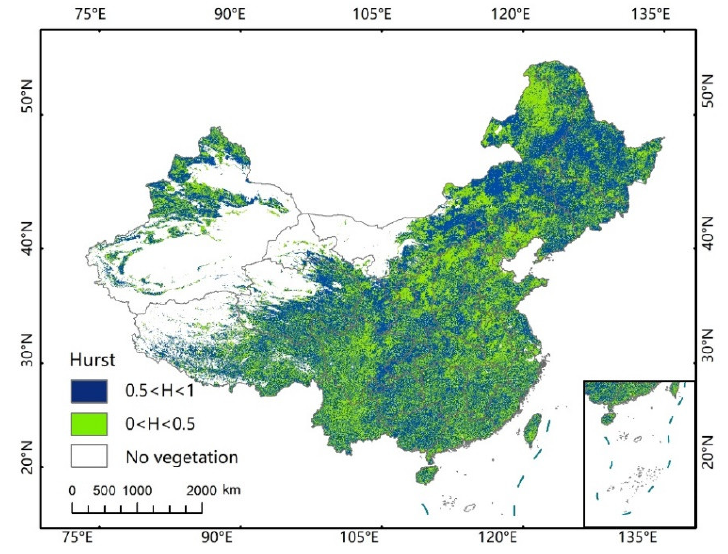
Figure 4. Hurst exponent for the annual average NDVI time series in China from 1998 to 2019.